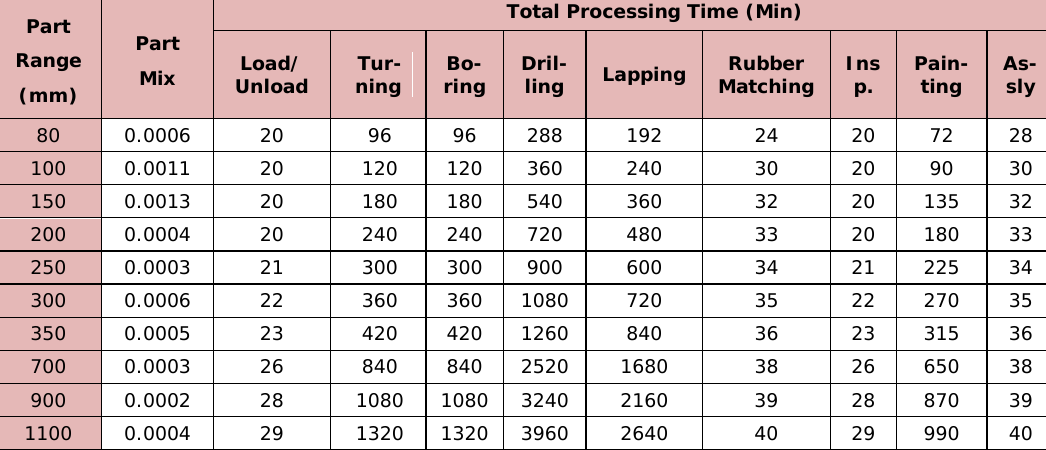
Table 1c. “Double Eccentric Butterfly Valve”. Source: Own contribution